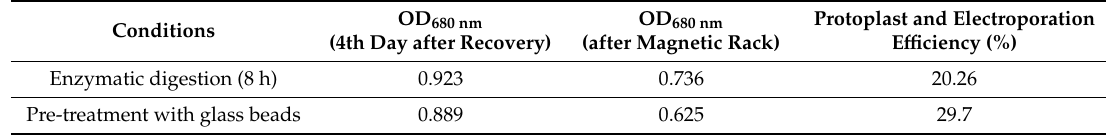
Table 1. Transformation e ffi ciency of H. pluvialis protoplasts.